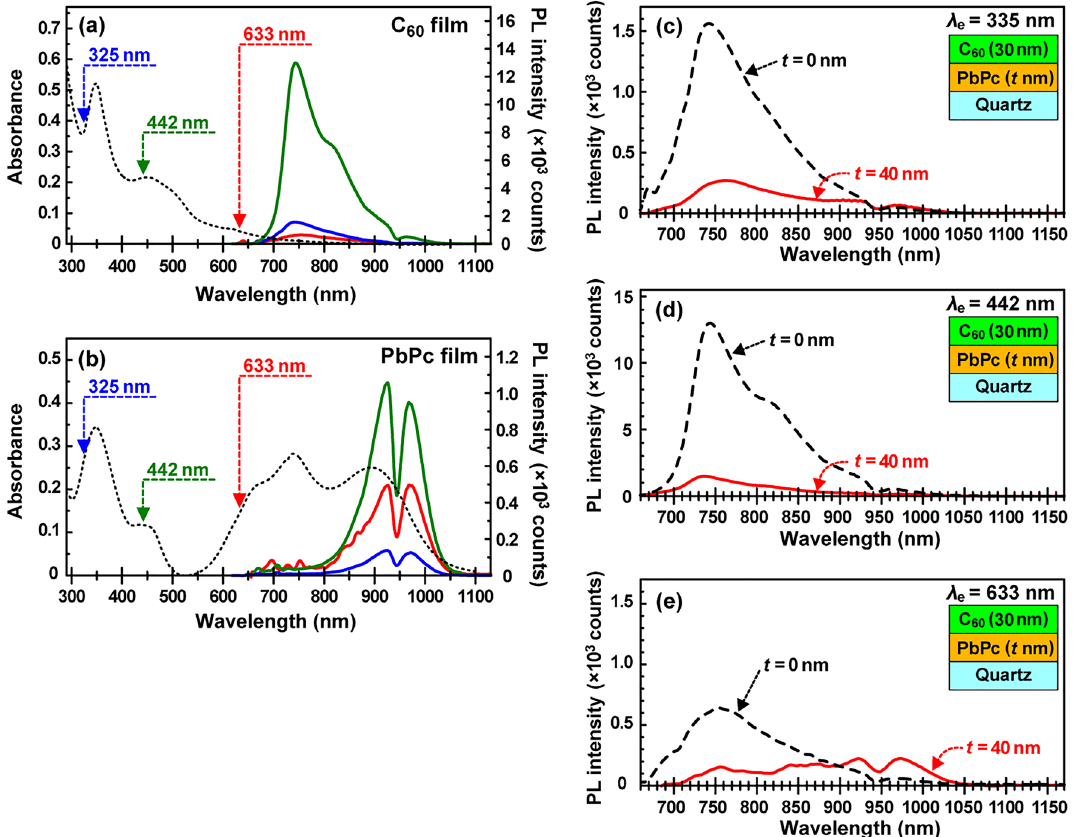
Figure 5. UV–vis-NIR spectra (black dashed lines) and PL spectra (blue, green, and red solid lines obtained at excitation wavelengths of 325, 425, and 633 nm, respectively) of ( a ) 30 nm-thick pristine C 60 film and ( b ) 40 nm-thick pristine PbPc film. PL spectra of the pristine 30 nm-thick C 60 (black dashed line) and [40 nm-thick PbPc/30 nm-thick C 60 ] bilayer (red solid line) films measured at excitation wavelengths of ( c ) 325 nm, ( d ) 425 nm, and ( e ) 633 nm,